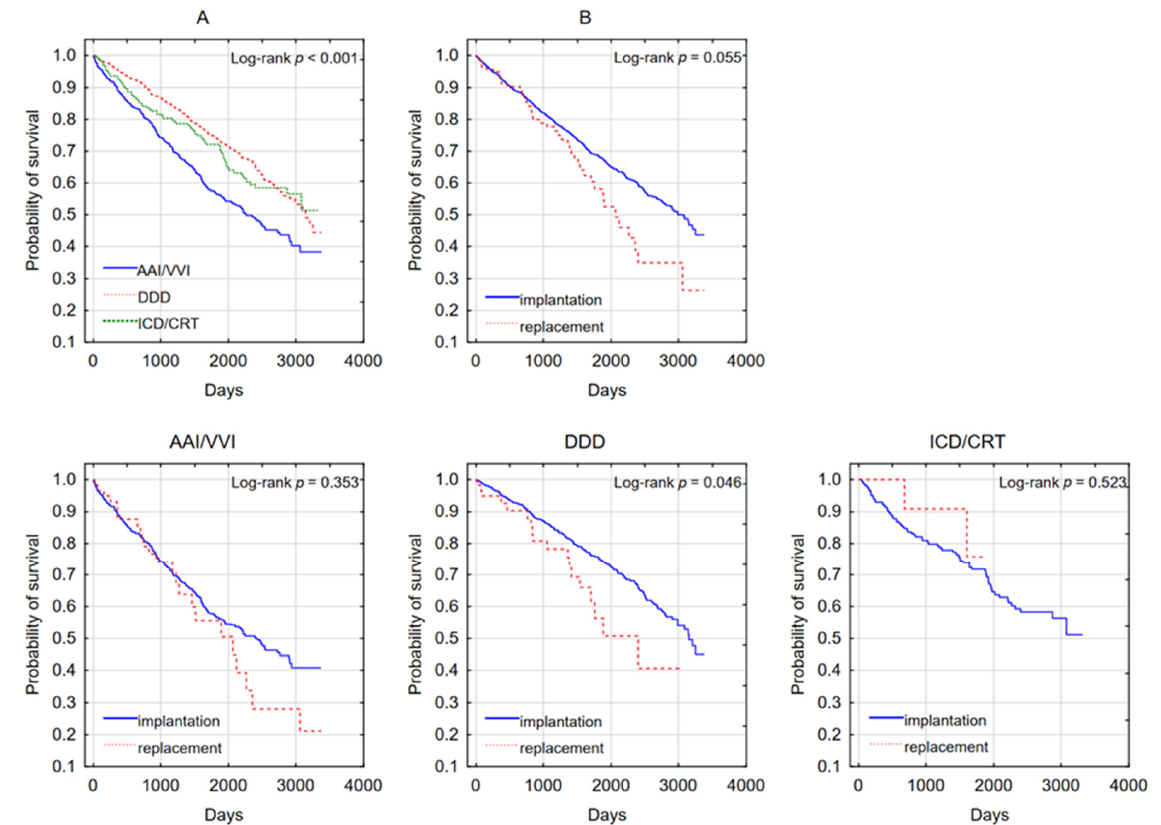
Figure 2. Kaplan–Meier life-table analysis in subgroups depending on the implementation or replacement and type of device. ( A ) The likelihood of patient survival, comparing three types of implanted devices. ( B ) The likelihood of patient survival depending on type of procedure (first implantation or